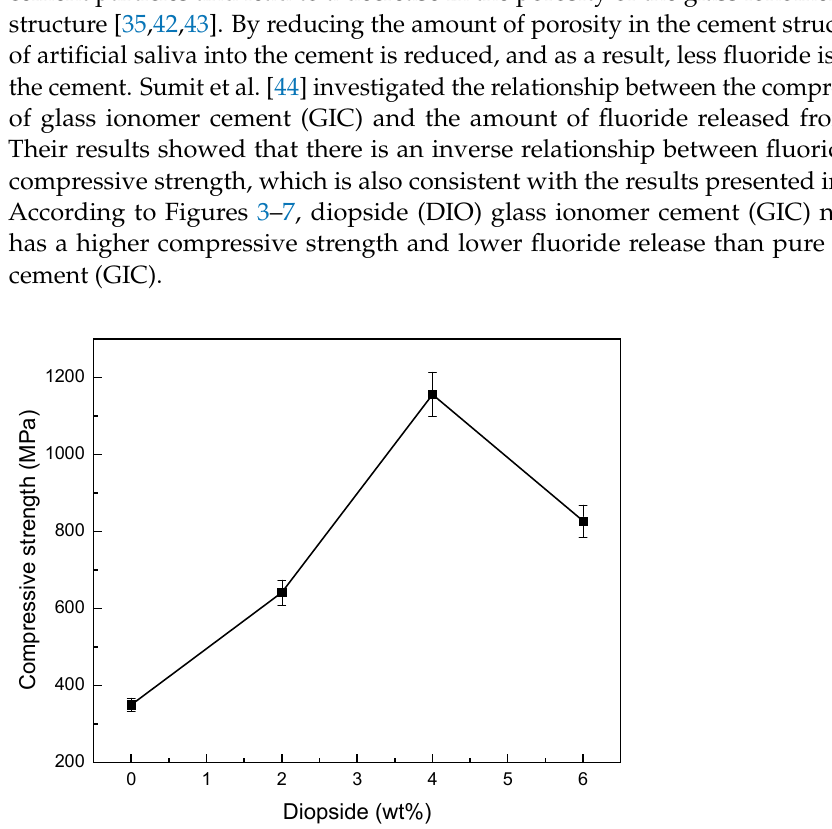
Figure 7. Compressive strength of glass ionomer and glass ionomer diopside with different weight